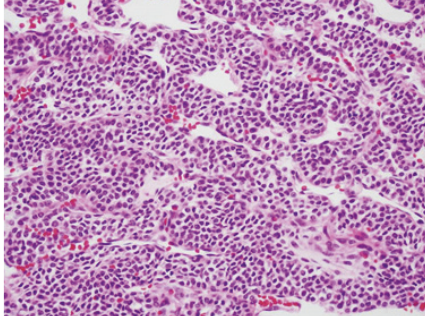
Figure 4: Histologic image of glomus tumor.